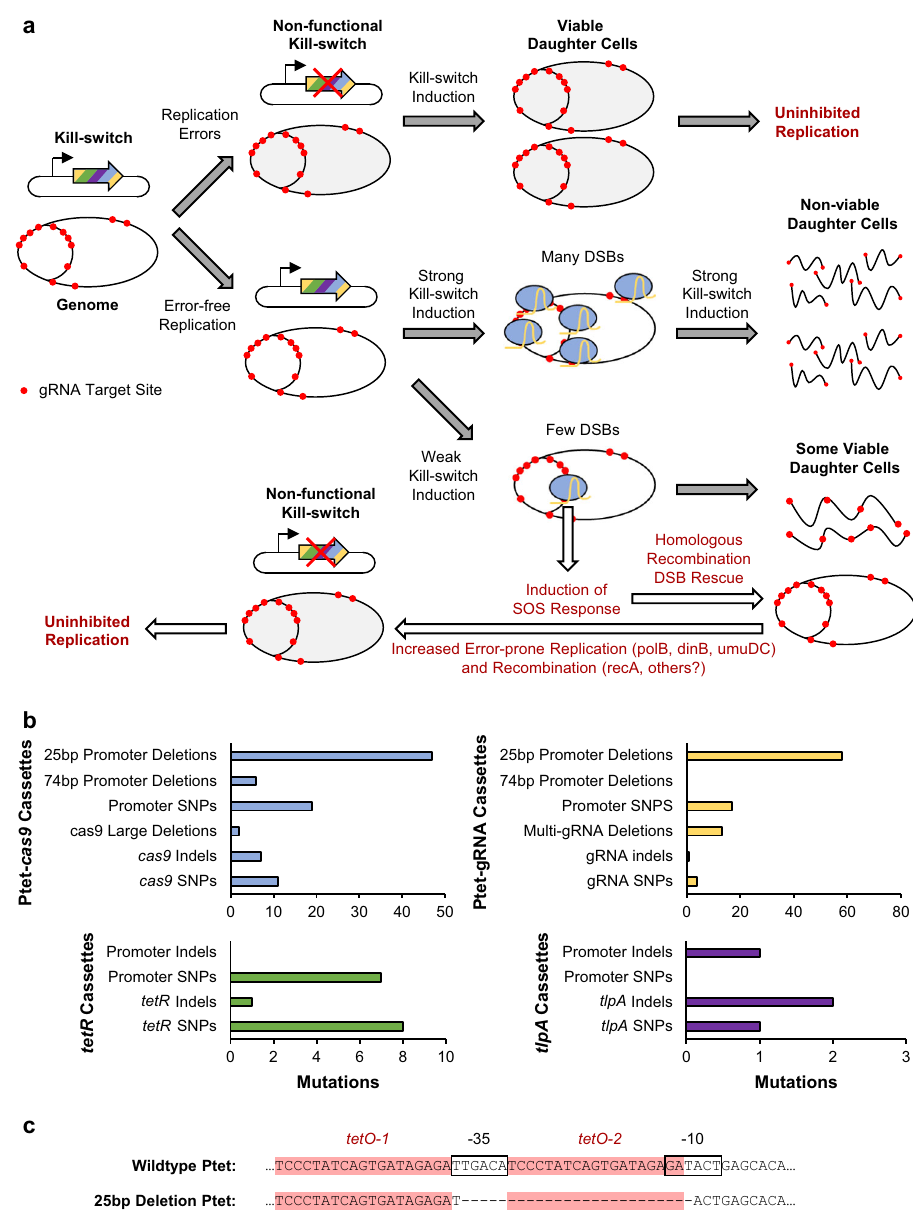
Fig. 6 Summary of sequencing results from non-functional kill switches and potential mechanisms of circuit inactivation. a Potential mechanisms of kill switch inactivation and cell survival. DSB, double-strand break. b Classi fi cations of the observed mutations in P tet - cas9 , P tet -gRNA, tetR , and tlpA expression cassettes. Source data are provided as a Source Data fi le. c Sequence of the most commonly observed inactivation mutation in the utilized P tet